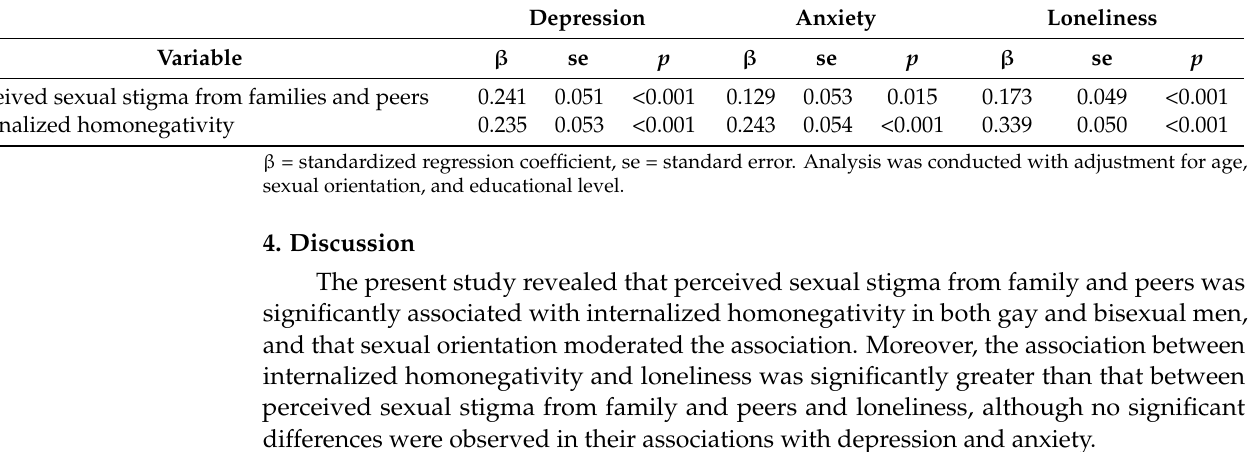
Table 3. Associations between perceived sexual stigma from family and peers and internalized homonegativity and depression, anxiety, and loneliness: multivariate linear regression analysis. Depression Anxiety Loneliness Variable β se p β se p β se p Perceived sexual stigma from families and peers 0.241 0.051 <0.001 0.129 0.053 0.015 0.173 0.049 <0.001 Internalized homonegativity 0.235 0.053 <0.001 <0.001 0.339